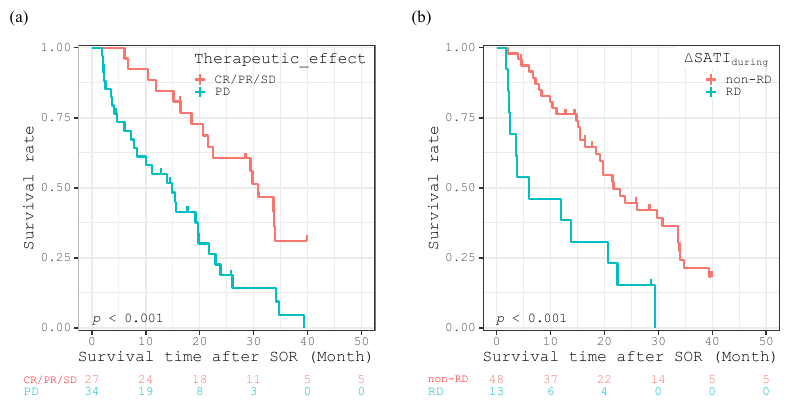
Figure 3. Kaplan-Meier curves for overall survival time after introducing sorafenib (SOR) divided into therapeutic effect (CR/PR/SD vs. PD) ( a ), and the rapid depletion (RD) or non-rapid depletion (non-RD) groups in Δ SATI during ( b ).